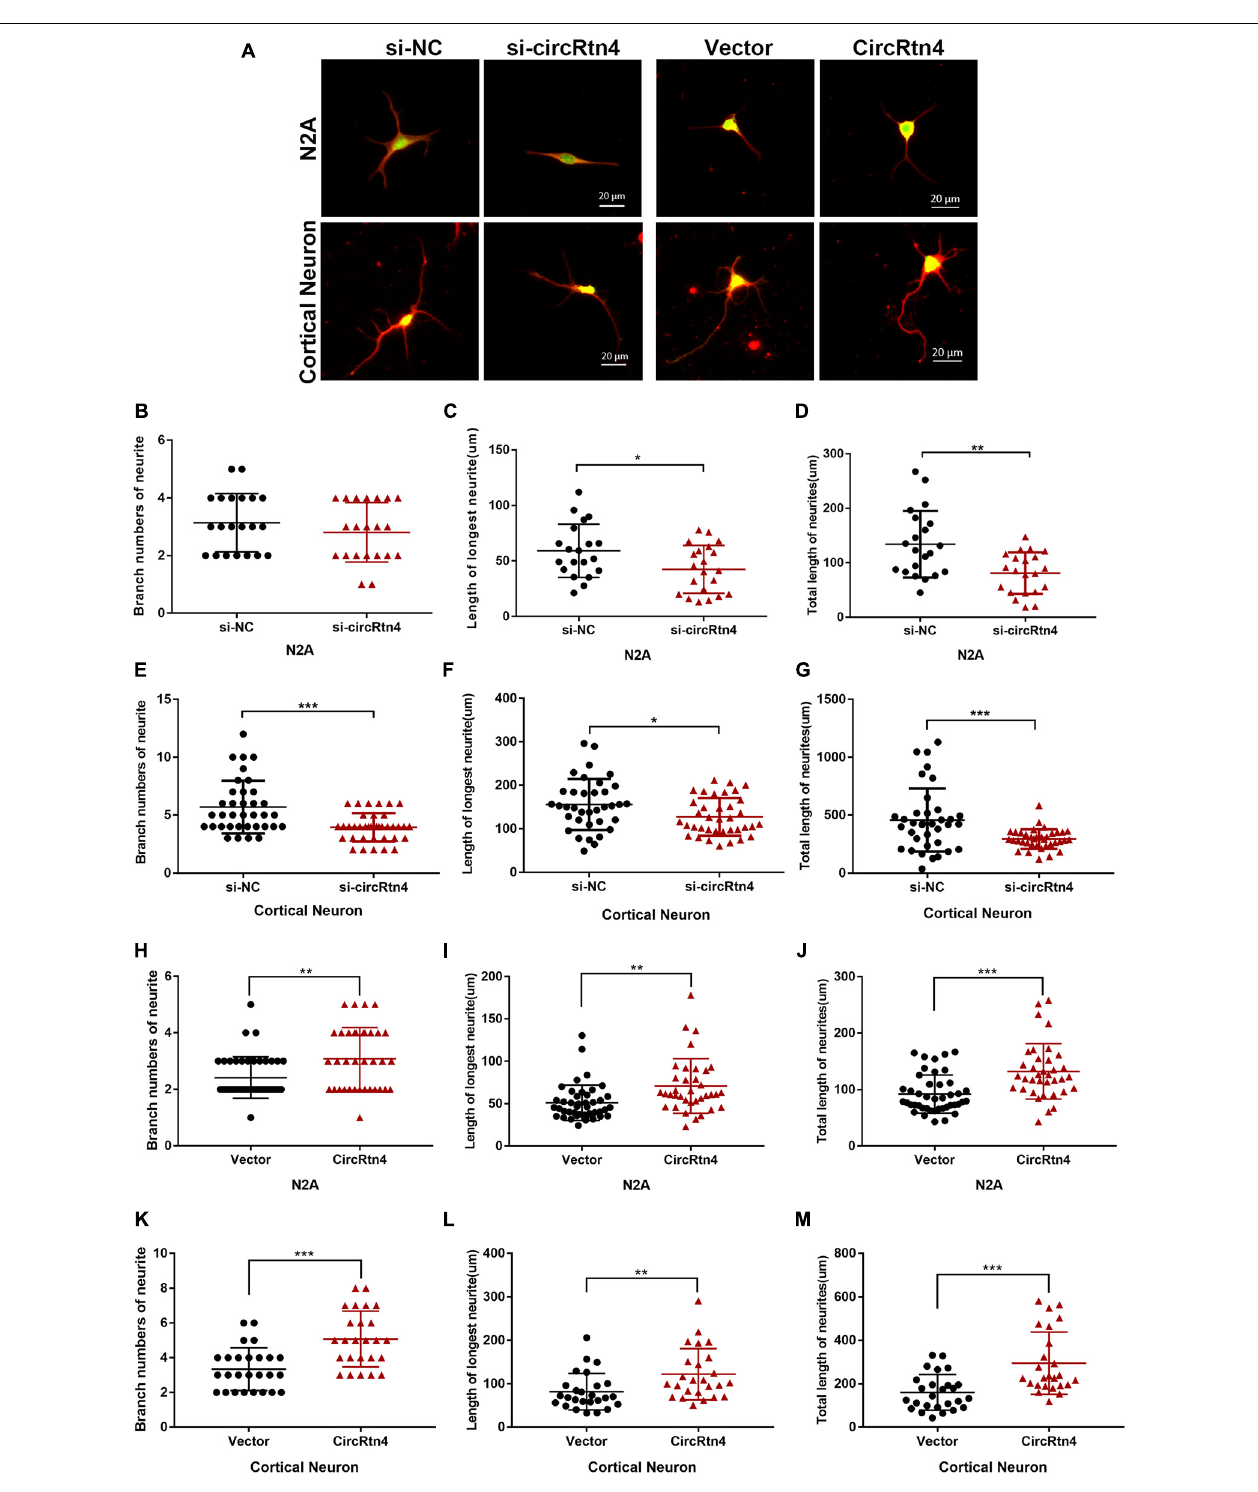
FIGURE 3 | CircRtn4 promotes neurite growth. (A) Following circRtn4 knockdown or overexpression, N2a cells and primary cortical neurons were fixed and immunostained with anti- β -tubulin III antibody and captured by a Zeiss LSM 710 confocal microscope with a 20 × objective (Red, β -tubulin III; Green, GFP). N2a cells (B–D) and cortical neurons (E–G) were cotransfected with siRNAs (100 nM) and PEGFP vector (250 ng/ml). N2a cells (H–J) and cortical neurons (K–M) were transfected with overexpression vector of circRtn4 (750 ng/ml). The branch numbers of neurite, the length of longest neurite and total length of neurites were quantified by Image-Pro Plus software. The results were shown as the mean ± SD (* p < 0.05, ** p < 0.01, and *** p < 0.001).